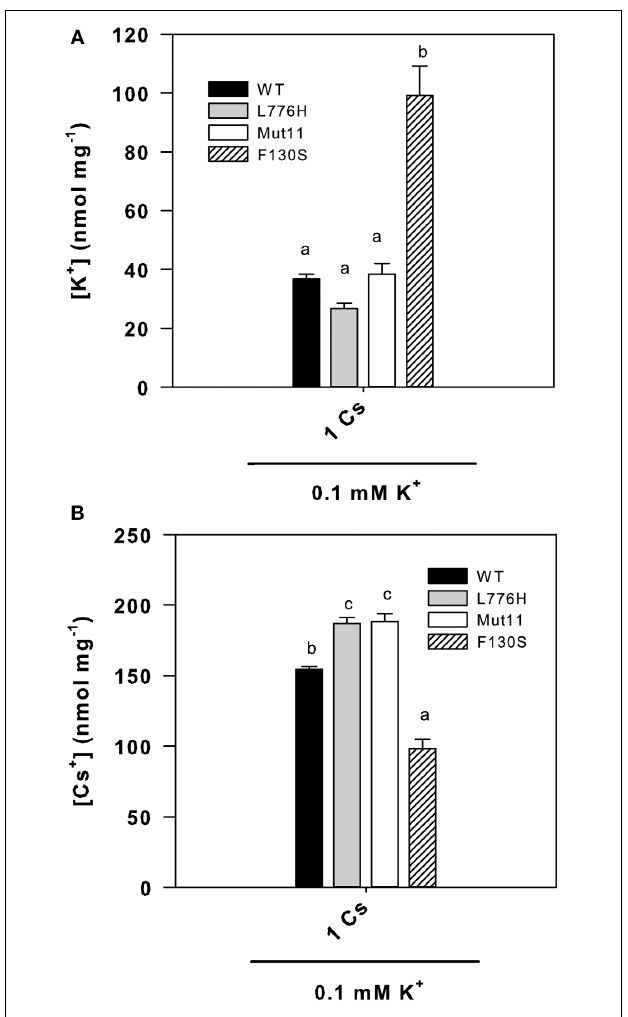
FIGURE 4 | Internal K + and Cs + concentrations of 9.3 yeast cells expressing WT AtHAK5 and mutated AtHAK5 K + transporters. The same strains described in Figure 1 were grown for 24h in minimal AP liquid media supplemented with 0.1mM K + and 1mM Cs + . After 24h cells were collected by filtration and their ionic content was acid extracted. The K + and Cs + concentrations in the acid extracts were determined by atomic emission spectrometry and the internal K + and Cs + concentrations calculated on a dry weight basis. Shown are averages of internal K + (A) and Cs + (B) concentrations of at least 6 replicates and error bars denote standard error. Columns with different letters within each ionic treatment are significant different according to Tukey test ( p < 0 . 01).